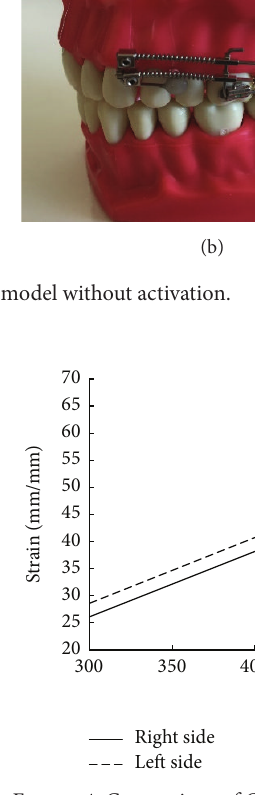
Figure 4: Comparison of Cise distalizer at right side and at left side under various